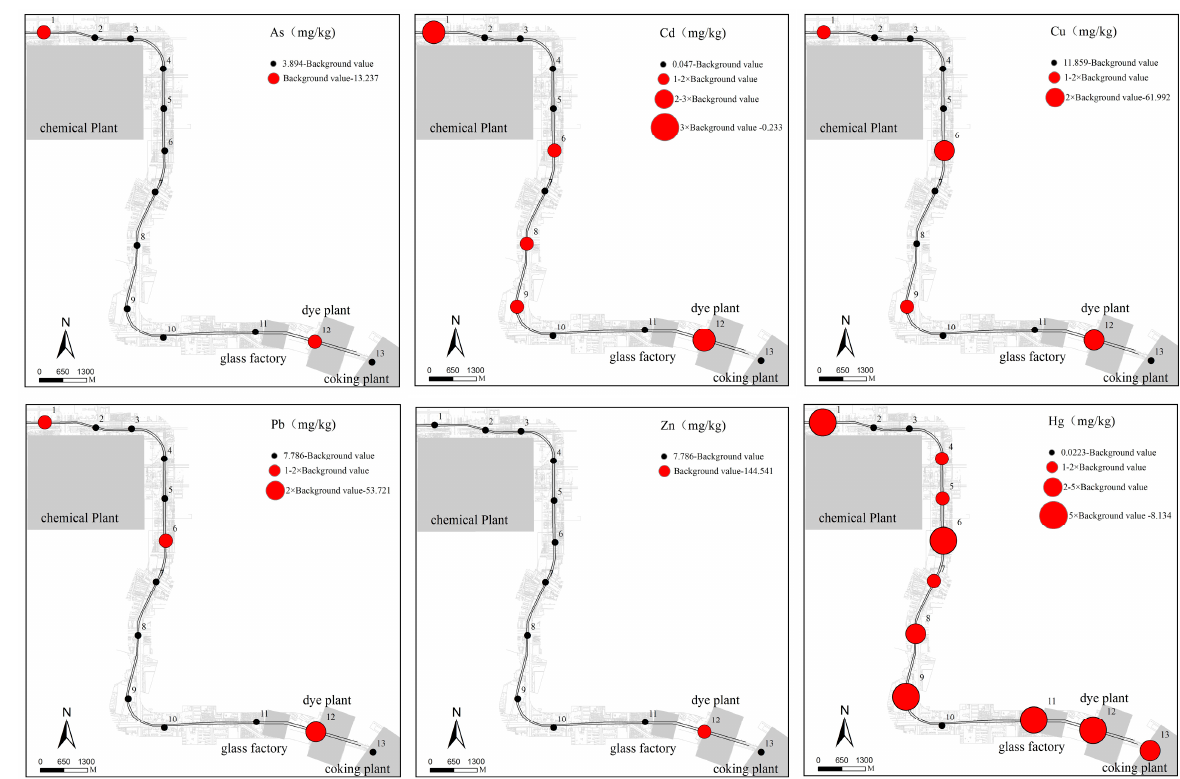
Figure 3. Horizontal distributions of the 6 excessive HMs in topsoil. Table 2. Correlation coefficient matrix of the HM concentrations in the